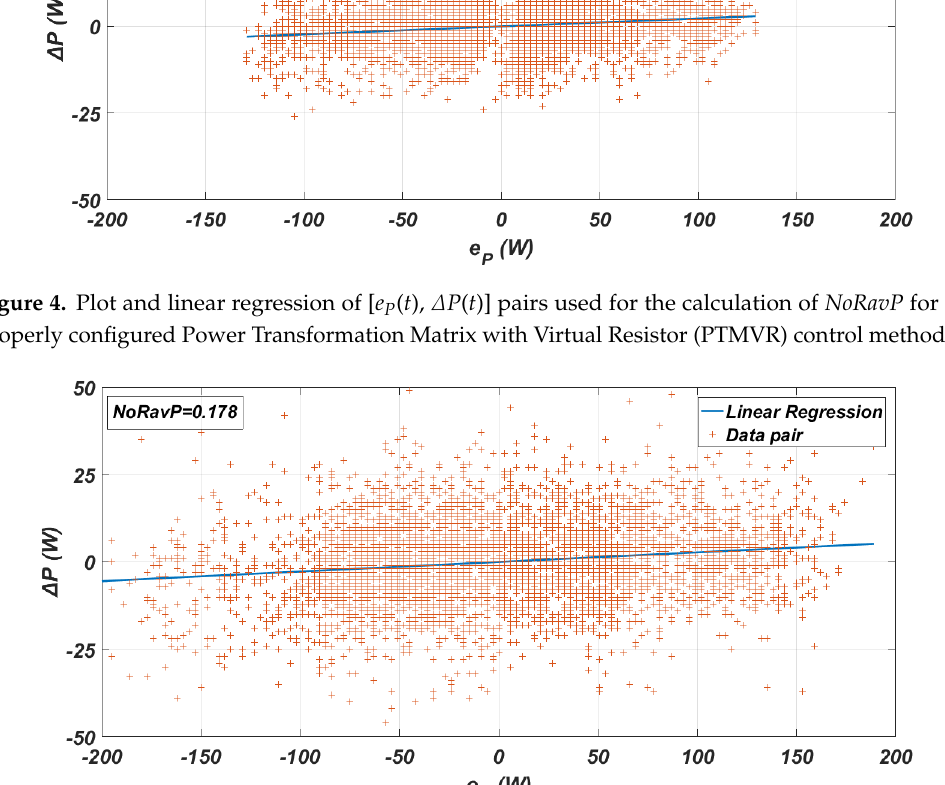
Figure 7. Plot and linear regression of [ e Q ( t ), ΔQ ( t )] pairs used for the calculation of NoRavQ for droop control.